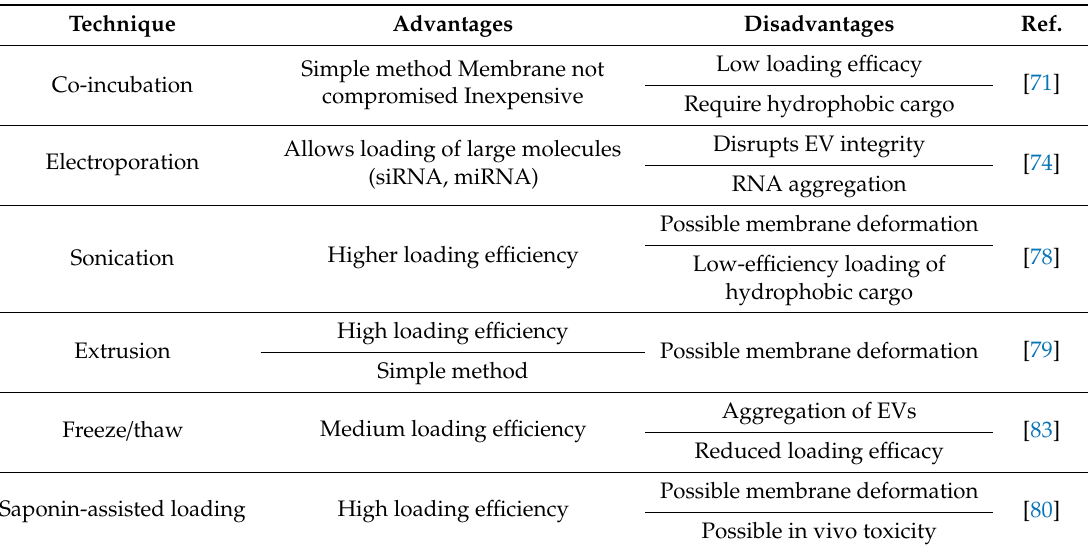
Table 2. Post-isolation EV loading